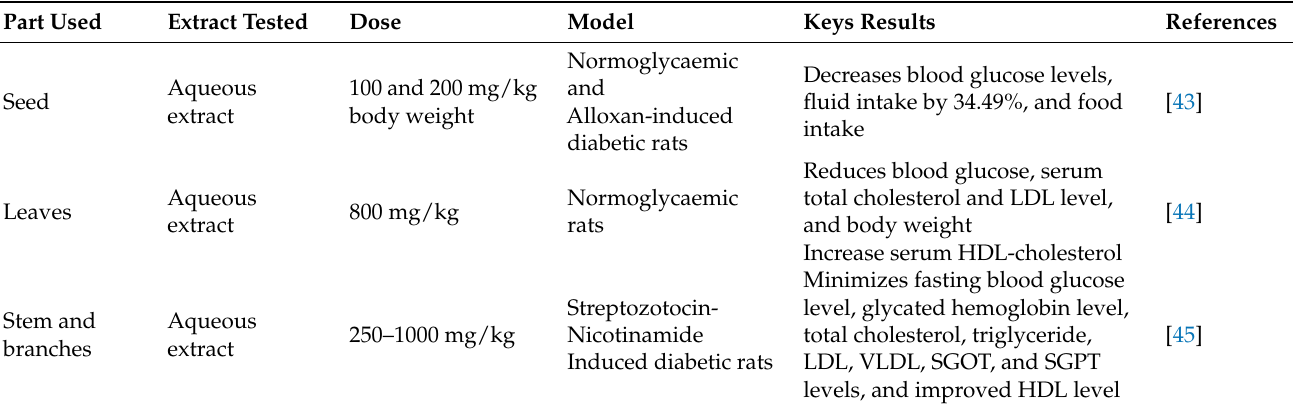
Table 7. In vivo antidiabetic effects of V. tortilis